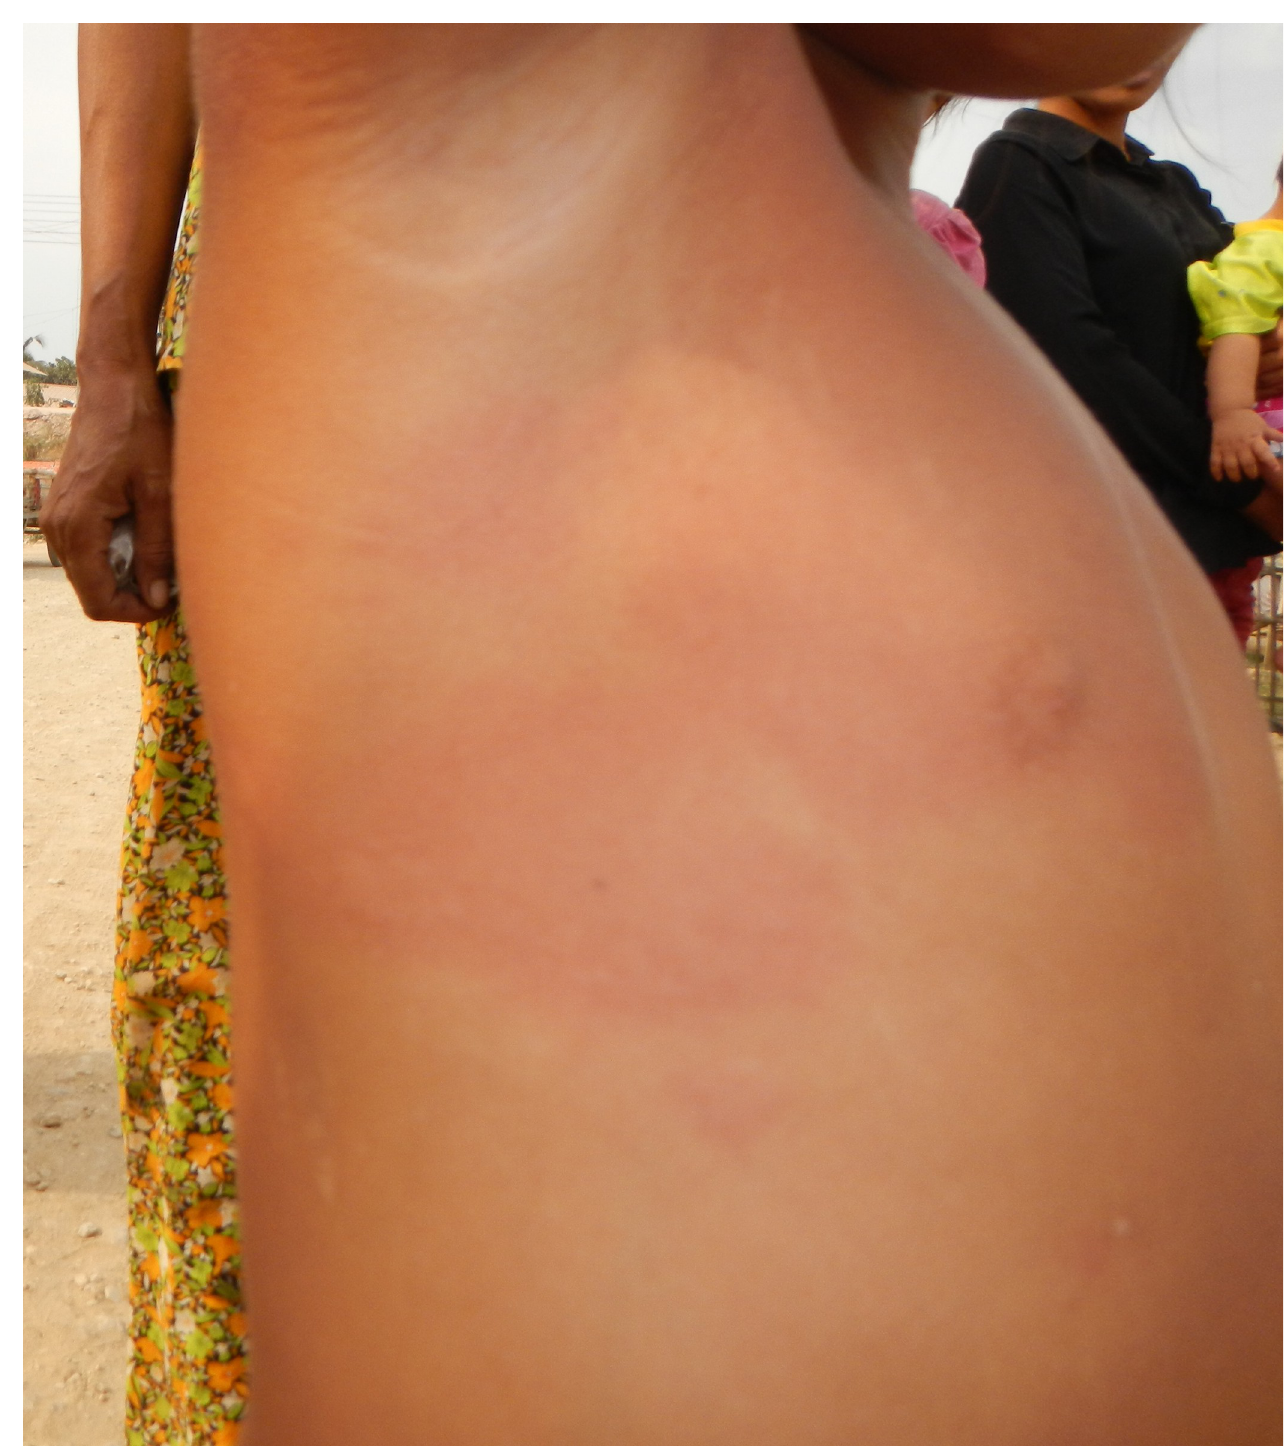
Fig 1. Generalized urticaria in a 5-year-old child which appeared at 25 hours following vaccination.